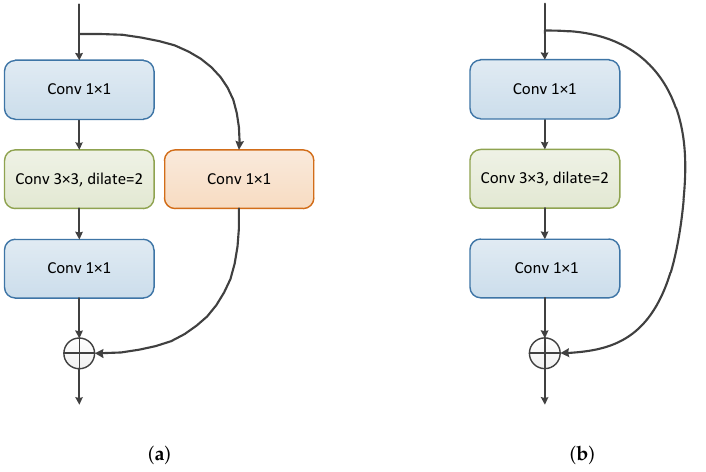
Figure 3. Illustration of the residual blocks in multiple receptive field feature integration. ( a ) Structure A with 1 × 1 convolutional mapping. ( b ) Structure B with identity